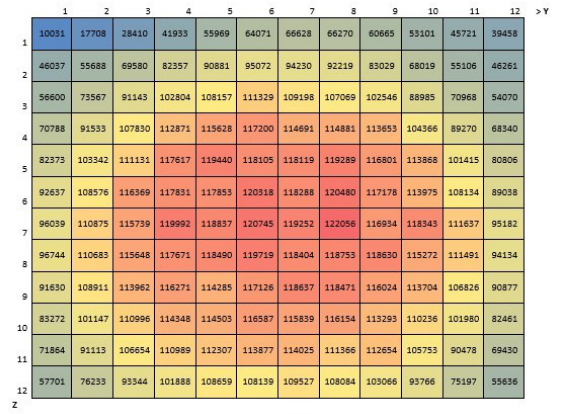
is on the Fig. 8. The axis x represents the values of the peak areas of 3 H and the axes y and z are the positions. The measurement uncertainty was around 1 %.